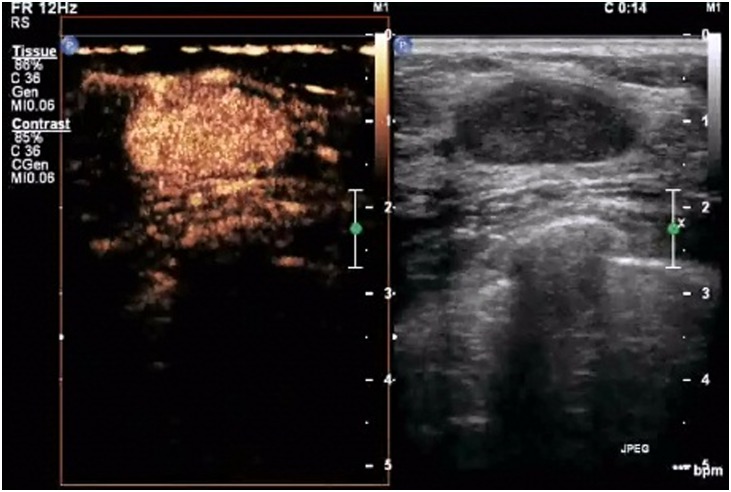
A lesion with a score of 3 by breast contrast-enhanced ultrasound.The lesion exhibits earlier enhancement compared with the surrounding tissue, homogeneous or heterogeneous, with a clear margin (sometimes with ring-like enhancement). The scope of the lesion is almost identical to that shown by 2D ultrasound.